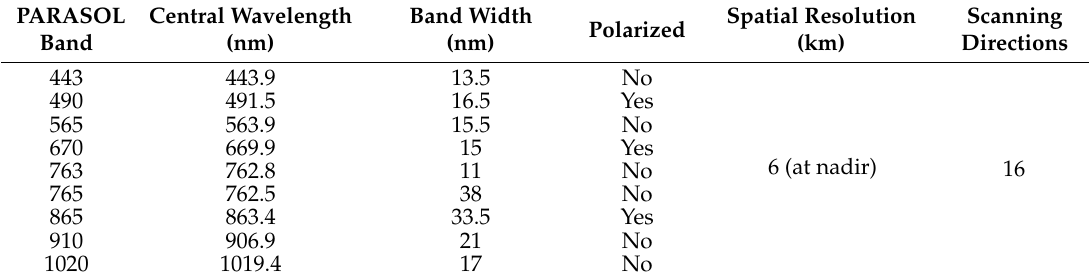
Table 1. Sensor parameters of PARASOL (Polarization and Anisotropy of Reflectances for Atmospheric Science coupled with Observations from a Lidar) [13].